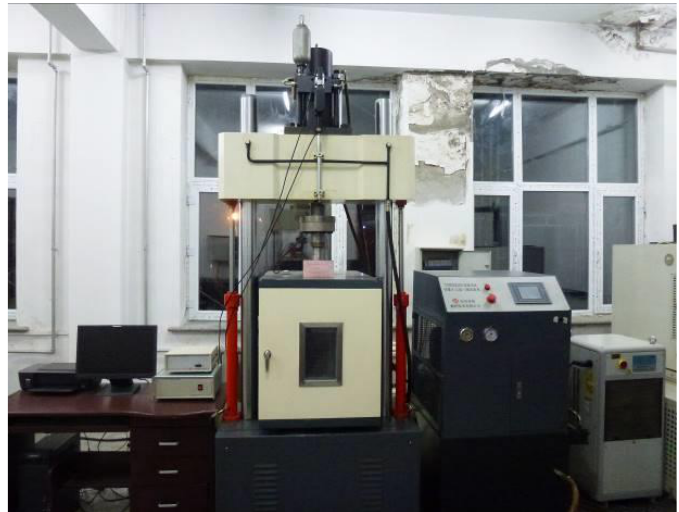
Figure 1. Testing apparatus (TWDSZ300).